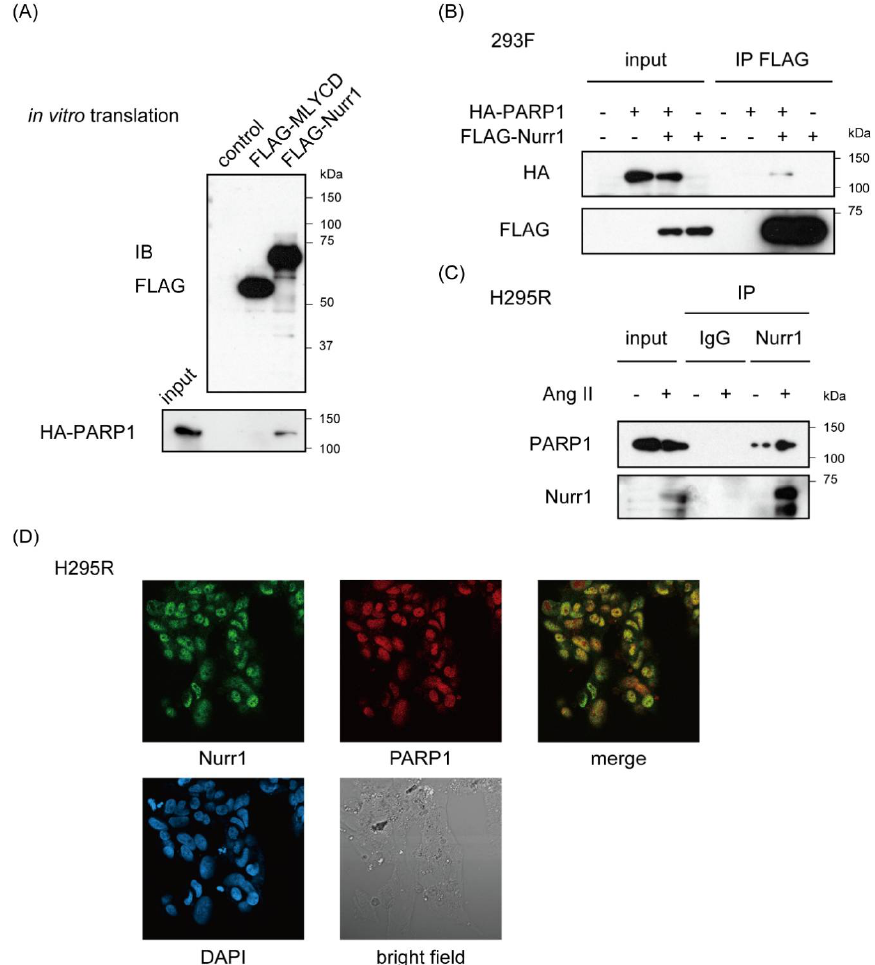
Figure 2. Stable protein complex formation of Nurr1 with PARP1 . ( A ) In vitro interaction between FLAG-Nurr1 and HA-PARP1. Confirmation of the expression level of each FLAG-tagged protein was shown on the upper image. Pull-down assay was performed with in vitro-translated proteins. Mixtures of indicated proteins were immunoprecipitated with FLAG-M2 agarose. FLAG-MLYCD protein was used as a negative control. Molecular weights of marker proteins are indicated on the right side; ( B ) Immunoprecipitation of 293F cells exogenously expressing FLAG-Nurr1 and/or HA-PARP1, followed by western blot analysis using indicated antibodies. Molecular weights of marker proteins are indicated on the right side; ( C ) Immunoprecipitation of H295R cells lysates stimulated with 100 nM angiotensin II (AngII) or not for 6 h, followed by western blot analysis using anti-Nurr1 and anti-PARP1 antibodies. Rabbit immunoglobulin (IgG) immunoprecipitates were used as a negative control. Molecular weights of marker proteins are indicated on the right side; ( D ) Confocal immunofluorescence detection of Nurr1 and PARP1 in H295R cells (magnification 40×). H295R cells stimulated with 100 nM angiotensin II (AngII) for 6 h were fixed with formaldehyde and stained with indicated antibodies. DAPI (4′,6-diamidino-2-phenylindole) staining and bright field images of the same area were shown in the lower panael.